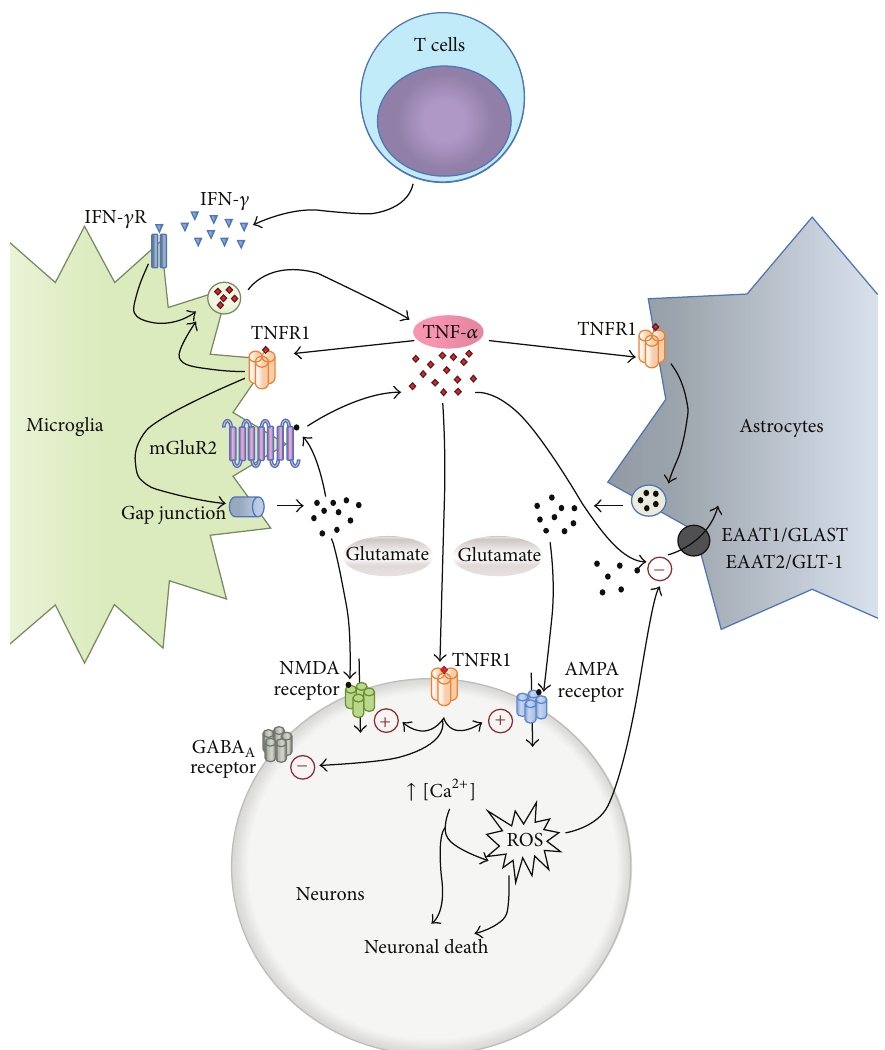
Figure 1: Proposed mechanisms by which TNF- 𝛼 links the neuroinflammatory and the excitotoxic processes. The cytokine IFN- 𝛾 , released by infiltrated T cells, activates TNF- 𝛼 production and release in microglia. TNF- 𝛼 , through TNFR1 signaling, promotes further microglial TNF- 𝛼 release and also induces glutamate release from hemichannels of gap junctions. In astrocytes, TNF- 𝛼 stimulates TNFR1 to induce glutamate exocytosis and also inhibits glutamate uptake, thus increasing extracellular glutamate levels. In neurons TNF- 𝛼 , via TNFR1, rapidly increases the excitatory synaptic strength by inducing increased Ca 2+ permeable-AMPA receptors and/or NMDA receptors and also decreases the surface expression of inhibitory GABA A receptors. The excessive Ca 2+ input to neurons induces neuronal death and generates excessive ROS that disrupt glutamate transport in neighboring astrocytes. The dying neurons maintain microglia in an active state, releasing TNF- 𝛼 .